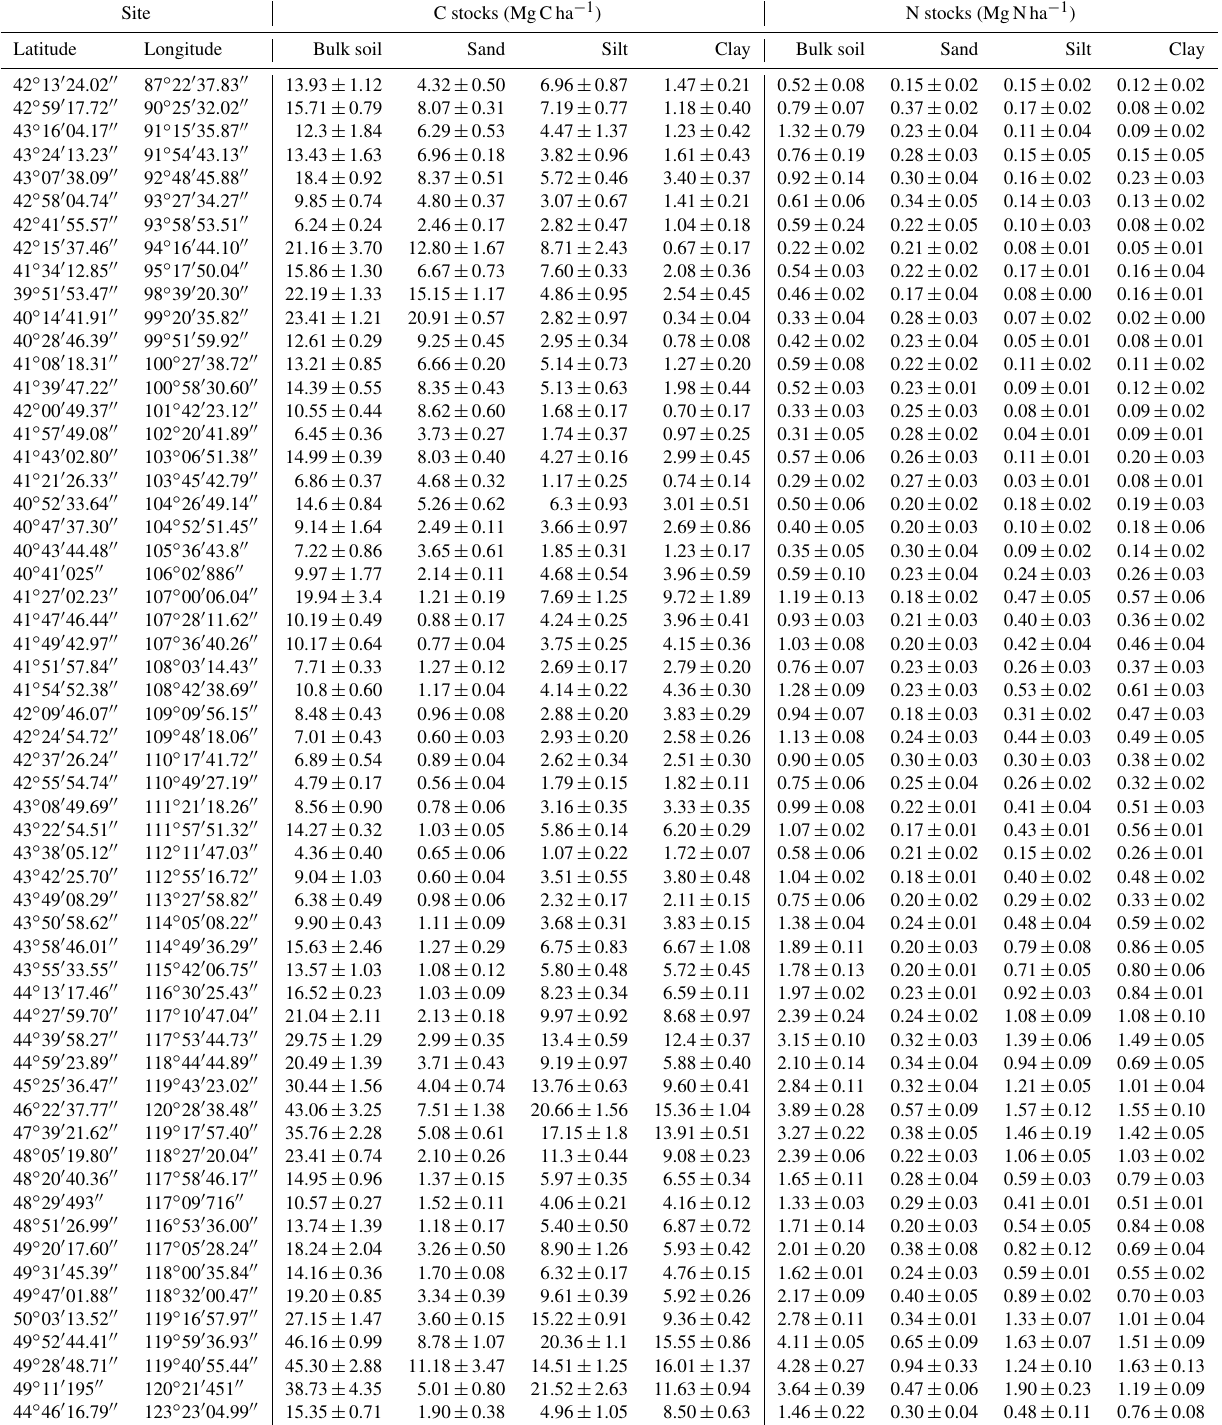
Table 2. Soil C and N stocks in bulk soils and different soil particle–size fractions (sand, silt, and clay) at 58 sampling sites in arid and semi-arid grasslands of northern China (data are represented as means ± 1SE, n =